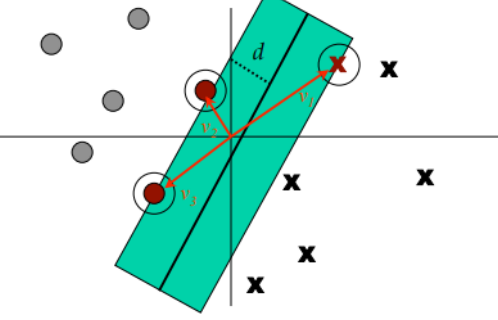
Figure 7. Support vector machine margin